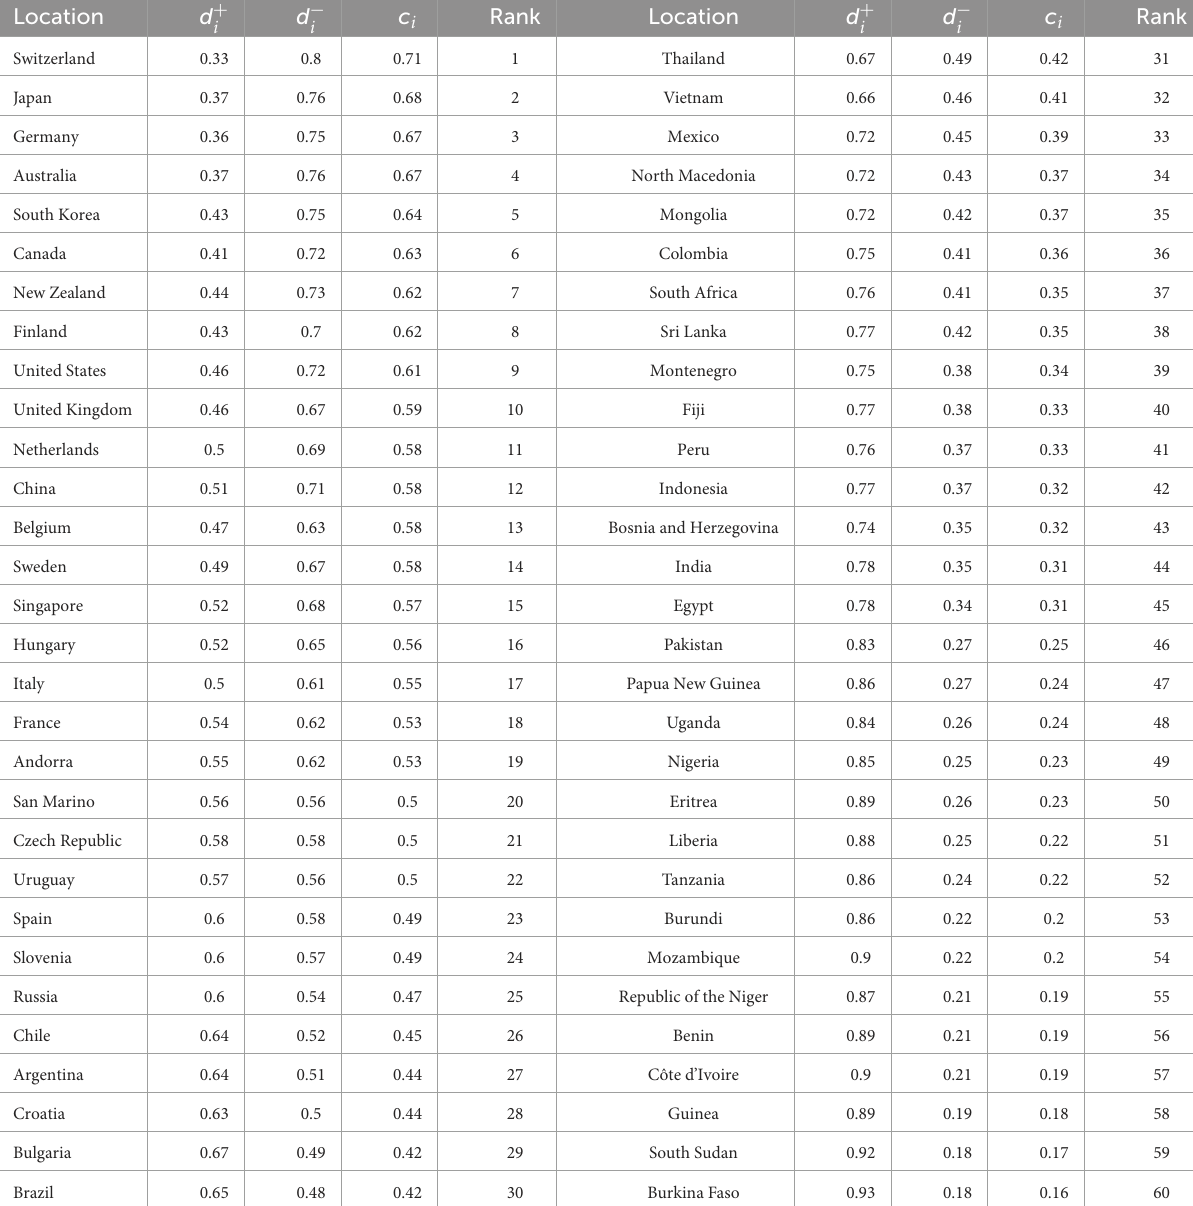
TABLE 1 Global health system resilience rankings of the 60 countries.